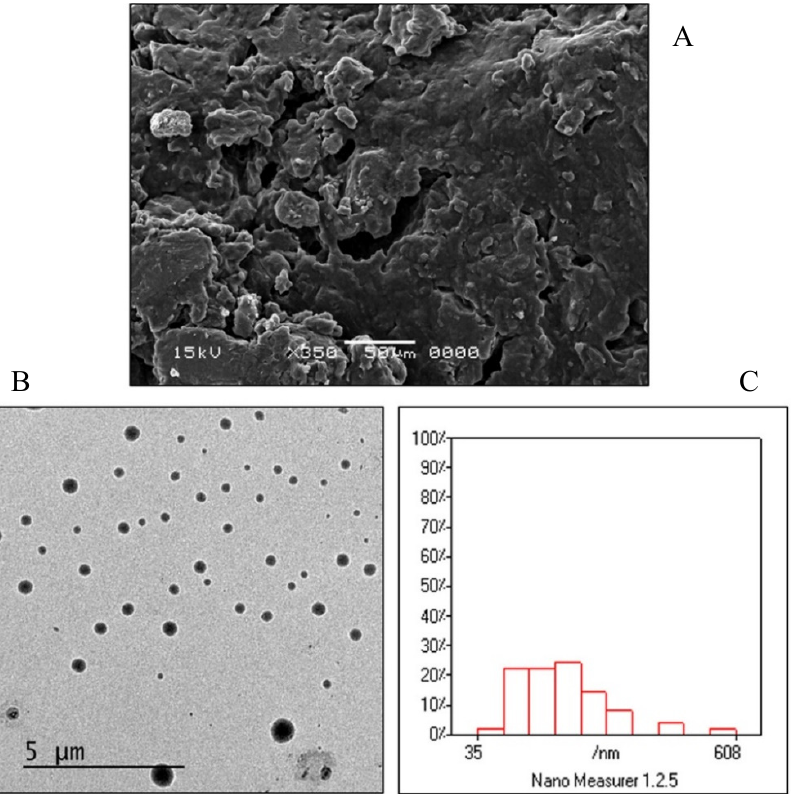
Figure 5. Morphological analysis of the FEX EIFV powder and the formed vesicles of the optimized formulation. ( A ) Scanning electron micrograph. ( B ) Transmission electron micrograph. ( C ) Analysis of the TEM image by Nano measurer ® software.